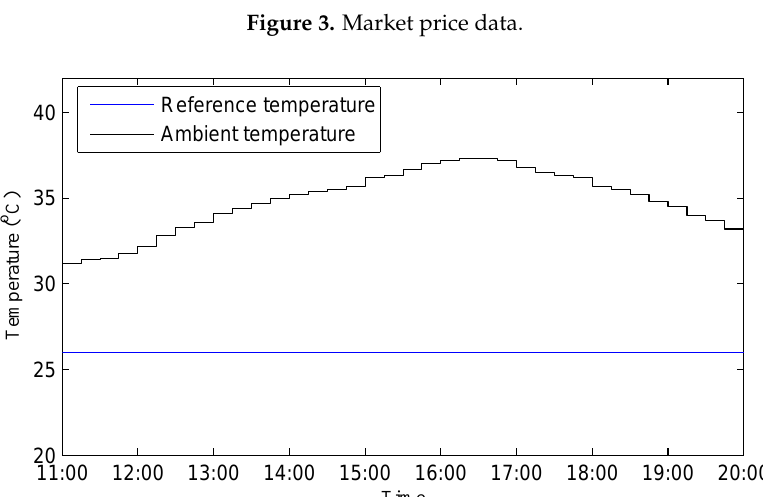
Figure 3. Market price data.